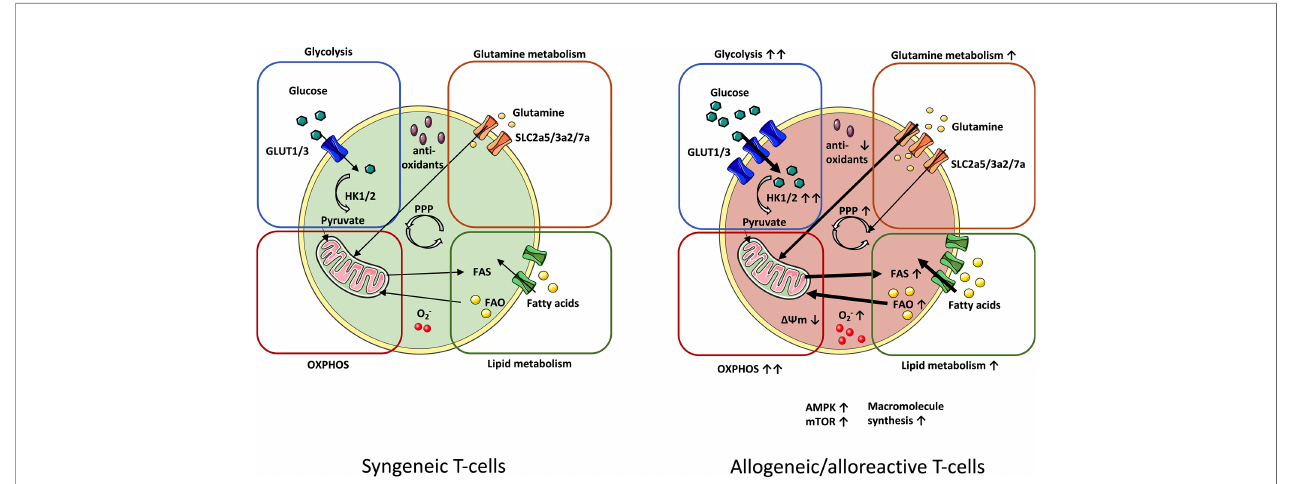
FIGURE 1 | Metabolic pro fi le of syngeneic vs. alloreactive T-cells. In order to meet their metabolic demands, GvHD-driving T-cells upregulate essential metabolic pathways. Glycolysis manifests as the principal source of energy in GvHD-causing T-cells. Fueling the TCA cycle with glycolysis-derived pyruvate reinforces increased OXPHOS activity in alloreactive T-cells. Enhanced OXPHOS potentiates production of ROS radicals (O 2- ), which is linked to lowered levels of antioxidants. Upregulation of glutamine metabolism further enhances OXPHOS by nourishing the TCA cycle with glutamine-derived a-ketoglutarate. Alloreactive/allogeneic T-cells display a superior lipid metabolism (FAS and FAO) and PPP-activity (fueled by glutamine as an anaplerotic source) as compared to syngeneic T-cells. Likewise, expression of the metabolic checkpoints AMPK and mTOR are elevated. Increased macromolecule synthesis complies with the demand of alloreactive T-cells for rapid cell growth and proliferation. AMPK, AMP-activated protein kinase; FAS, Fatty acid synthesis; FAO, Fatty acid oxidation; GvHD, Graft- versus -host-disease; mTOR, Mammalian target of rapamycin; OXPHOS, Oxidative phosphorylation; PPP, Pentose phosphate pathway; TCA, Tricarboxylic acid